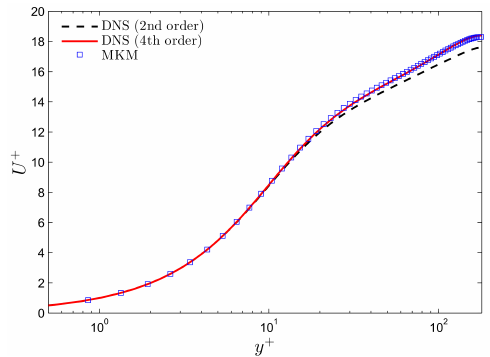
Figure 8. Mean streamwise velocity of turbulent channel flow at Re τ = 180 by DNS.